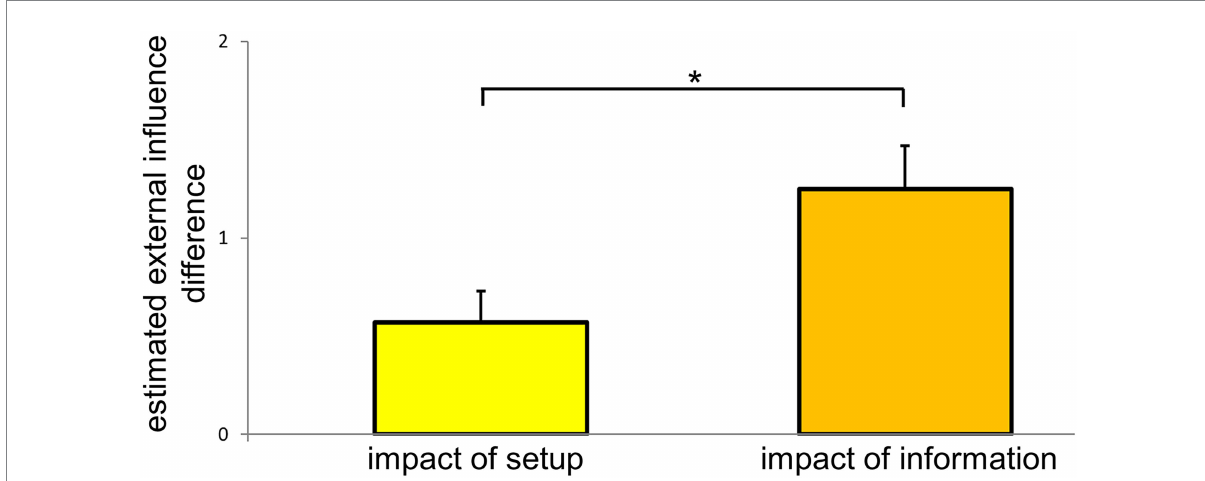
FIGURE 3 Comparison of “impact of setup” and “impact of information.” “Impact of setup” is the difference of the estimated external influence between the conditions “setup & negation” and “no setup & negation,” which differ in the presence and absence of the setup, respectively. “Impact of information” represents the difference between the estimation of external influence in the condition “setup & confirmation” minus “setup & negation.” In the first condition participants were informed that external influence is attempted (confirmation), whereas they were informed that no external influence is attempted (negation) in the second condition. * p < 0.05. Mean values and standard error of the means are